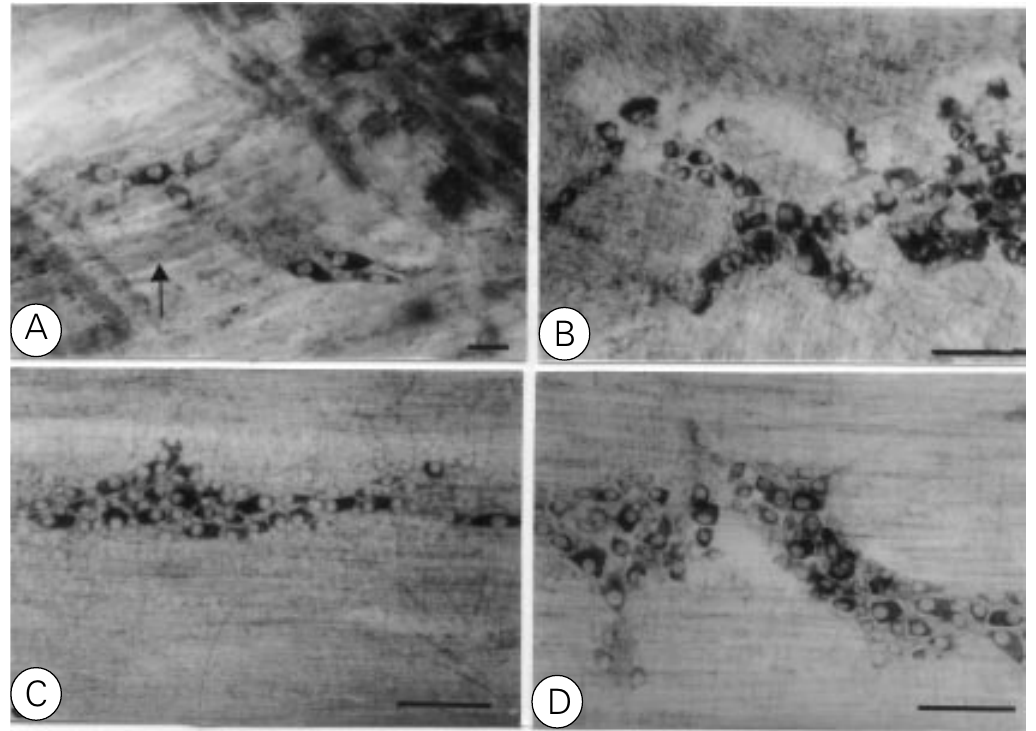
Figure 1 - Histochemically stained myenteric ganglia from Calomys callosus. A , Esophageal ganglia. Note the striated musculature of the esophagus (arrow). B , Large ganglion from the stomach. Note the variation in neuronal size. C , Large ganglion from the jejunum showing a densely packed cluster of neurons. D , Ganglion from the sigmoid colon. Note the variation in the intensity of the reaction among the neurons. Scale bars = 20